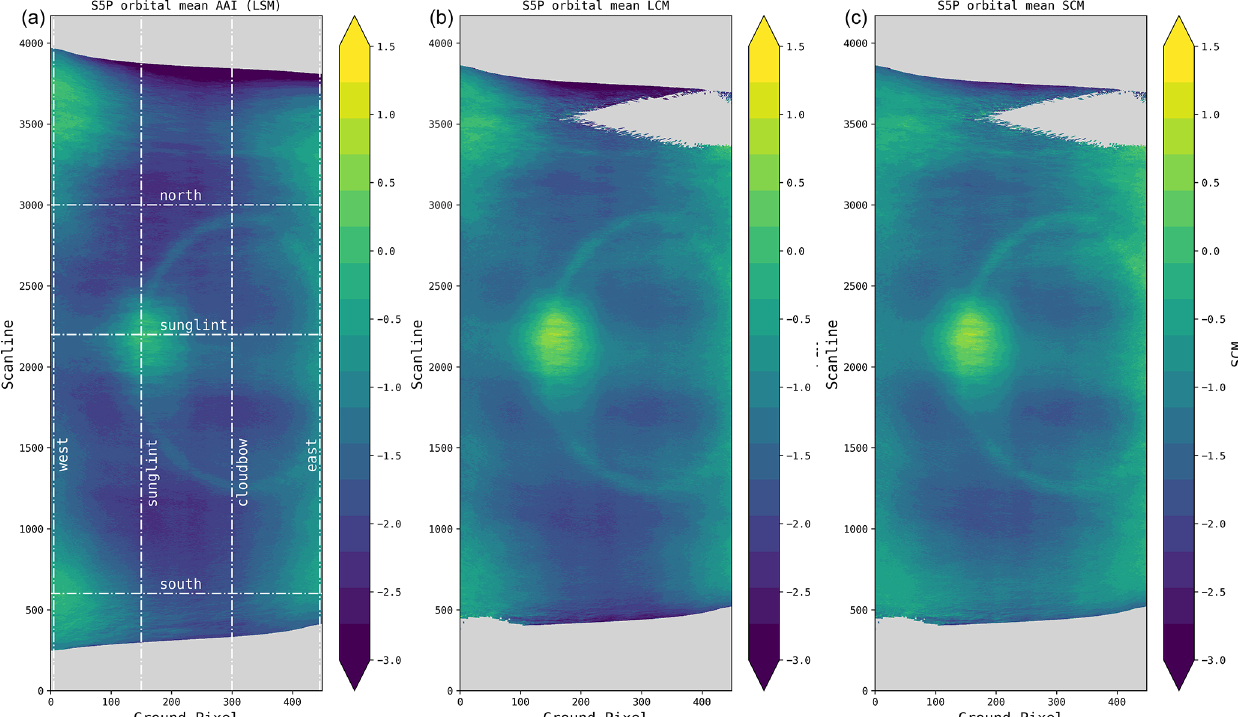
Figure 11. Mean orbital distribution of (a) the original TROPOMI AAI retrieval using the LSM method, (b) the LCM retrieval, and (c) the SCM retrieval. The dashed white lines indicate the cross sections used in Figs. 12 and 13. Panels (b) and (c) clearly show a more homogeneous field than the original AAI retrieval. Here the same 54 orbits over the Pacific are used as in Fig. 4a; all cloud fractions are